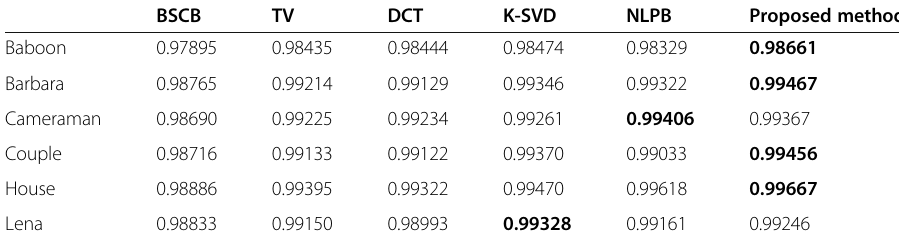
Table 4 The SSIM of each method for removing scratches